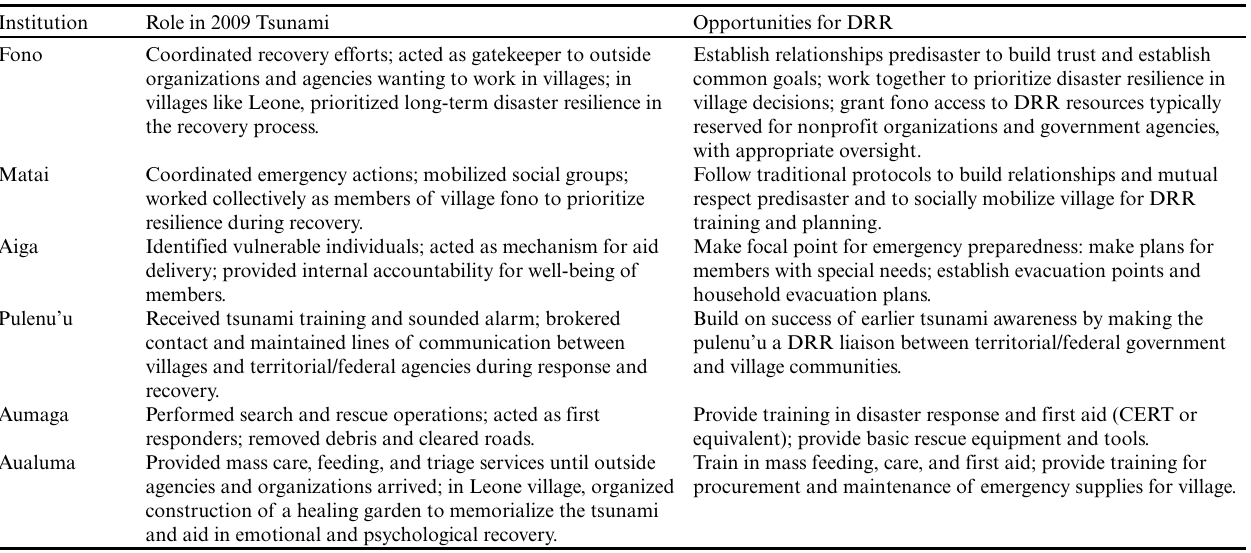
Table 2 . Indigenous institutions, their role in the 2009 tsunami, and opportunities for disaster risk reduction (DRR).